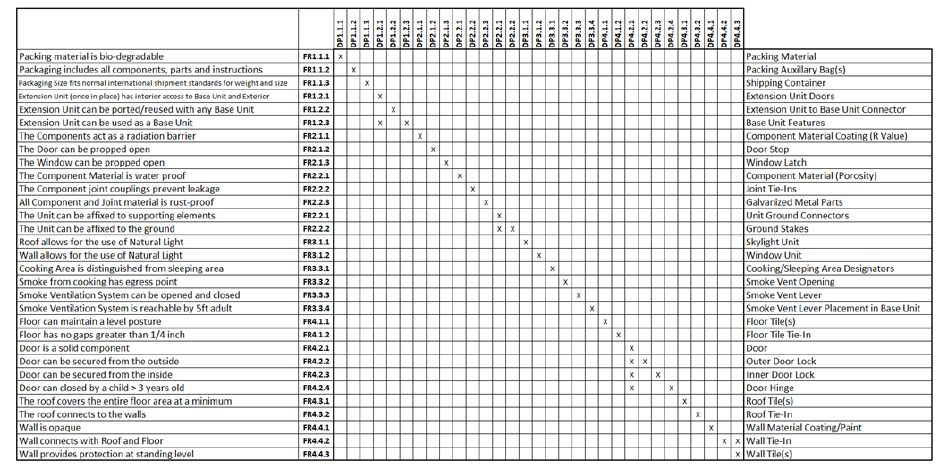
Figure 23. AD Level 3 FR to DP mapping, showing a decoupled design. From each individual pair of FR1. . . 4 × DP 1. . . 4 mappings, the complete Design Matrix (Level 3) was constructed (Figure